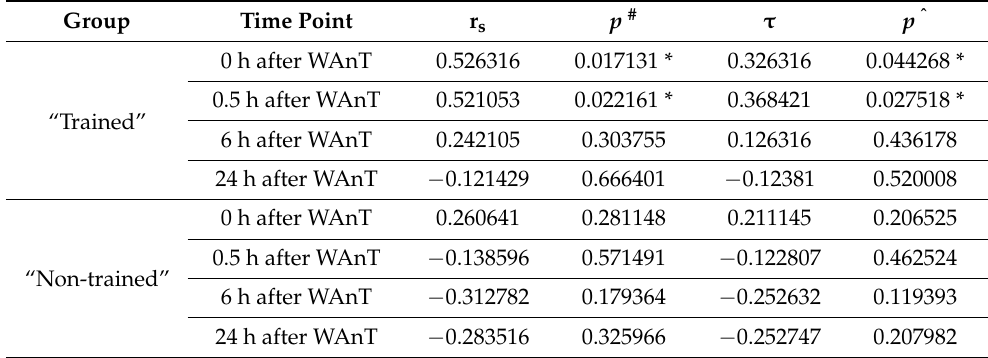
Table 1. The results of correlation analyses carried out for comparisons between the expression level of the CCL2 gene and the CCL2 protein.